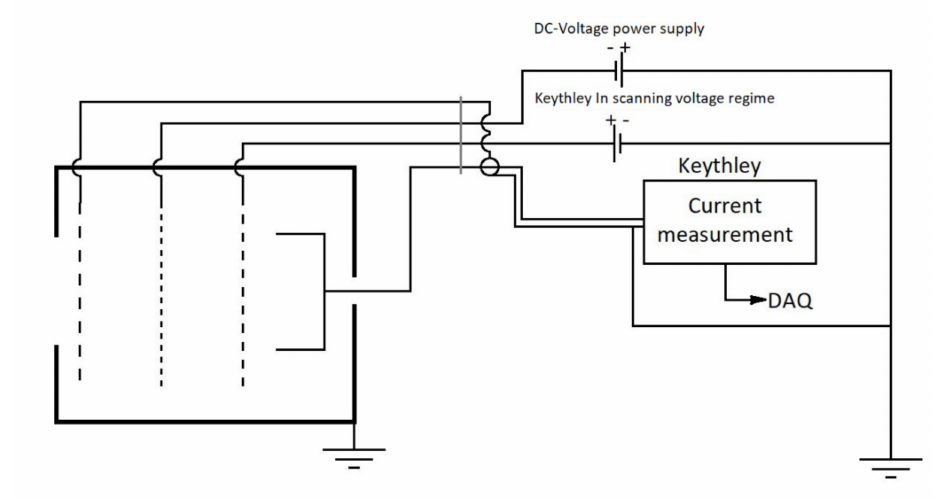
Figure 9. Retarding potential analyzer electrical